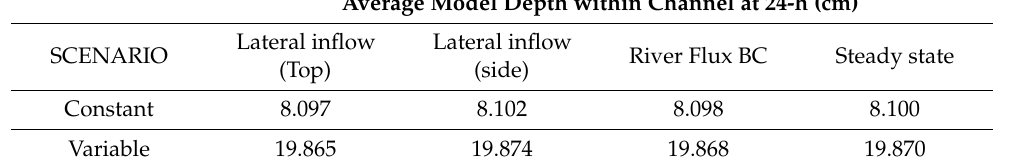
Table 2. Comparison of the model results and steady state water depths for both the constant and variable scenarios: simulated with river flux boundaries and lateral inflows (point